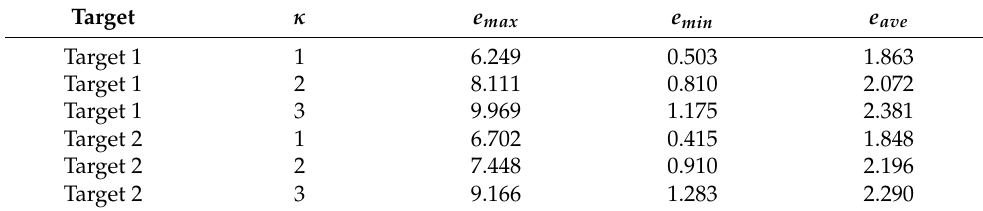
Table 3. Comparison of positioning errors with different initial states.